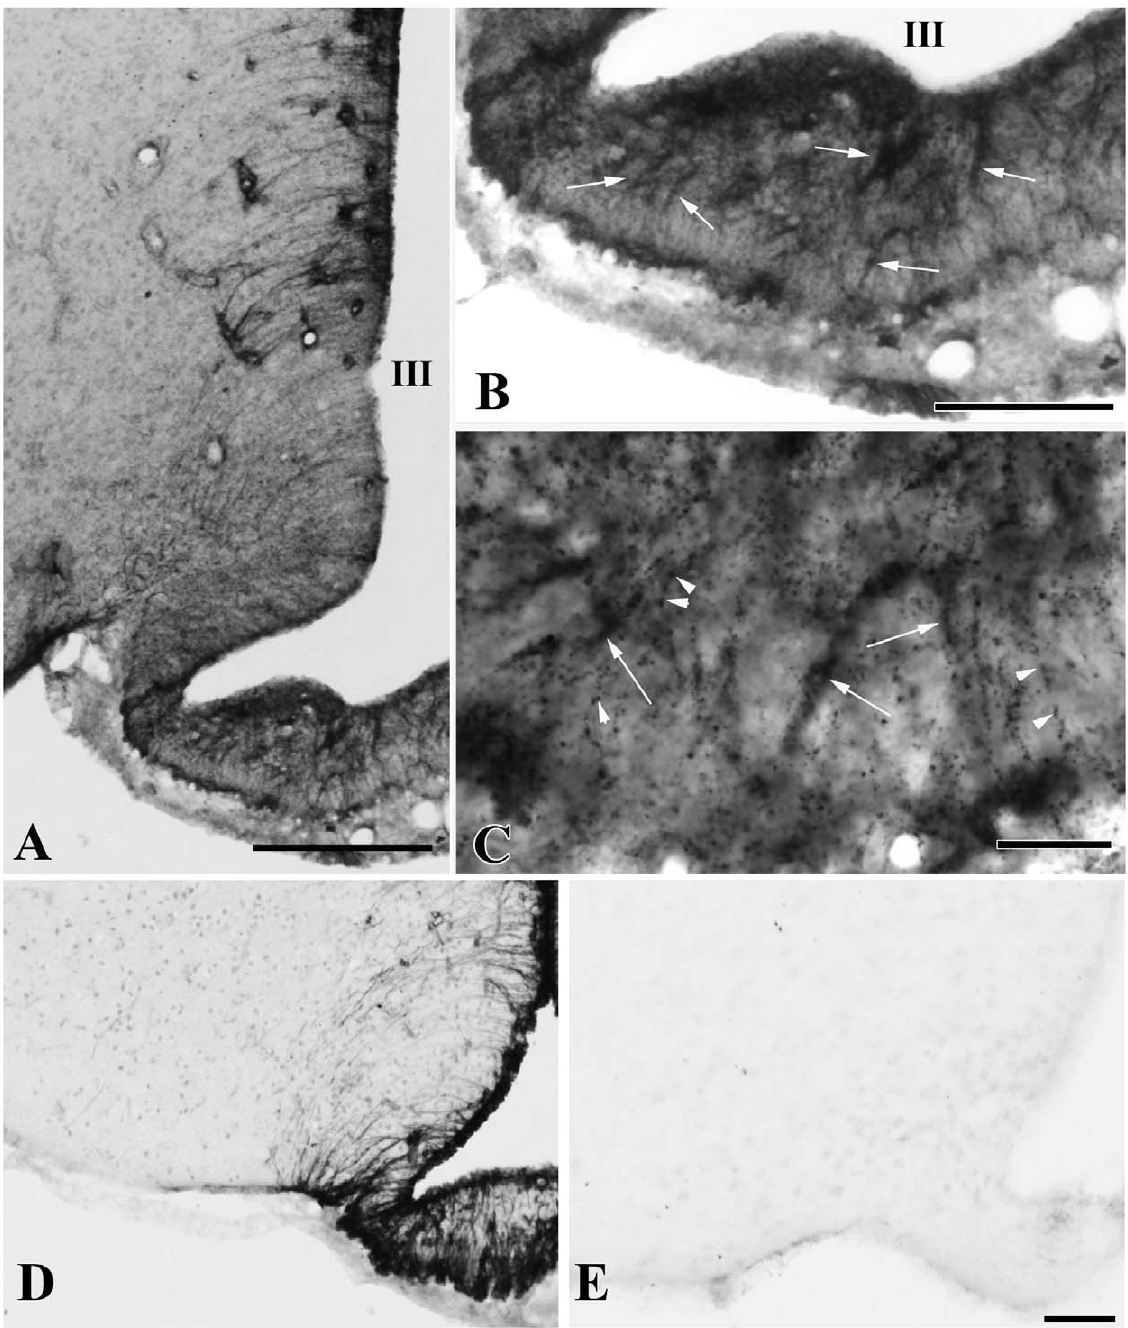
Figure 7. MCT8 immunoreactivity in the rodent mediobasal hypothalamus. Low magnification photograph illustrates the presence of MCT8-immunoreactivity associated with tanycytes ( A ). In the median eminence, strong MCT8-immunoreactivity is observed in tanycyte processes ( B, arrows ). In addition to occurring in tanycyte processes (arrows), MCT8-immunoreactivity is also observed in small dot like structures reminiscent of axon varicosities (arrow heads) ( C ). MCT8 immunoreactivity in the mediobasal hypothalamus of wild-type ( D ) and MCT8-KO mice ( E ). III, third ventricle; Scale bars: 200 m m in A, 100 m m in B, 20 m m in C, 50 m m in D,E.